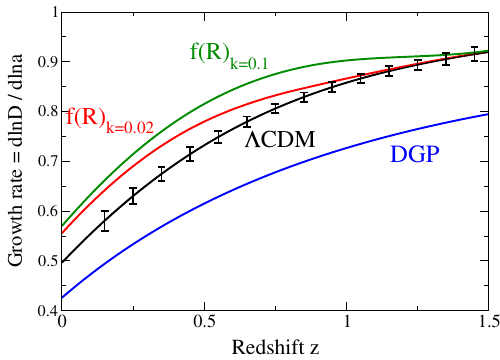
Fig.1 Growth rateofmatter densityfluctuations, f ( z ) .Theorypredictioncurvesareshown for:the Λ CDM model;theDvali–Gabadadze–Porratibraneworldmodel(theself-acceleratingbranch,seeSect.7.5.2)(Dvali et al. 2000); and the f ( R ) (see Sect. 7.4.1) modified gravity model (Hu and Sawicki 2007a) [model with c = 3 from Linder (2009)]. Note that the growth in f ( R ) models is scale-dependent so the authors